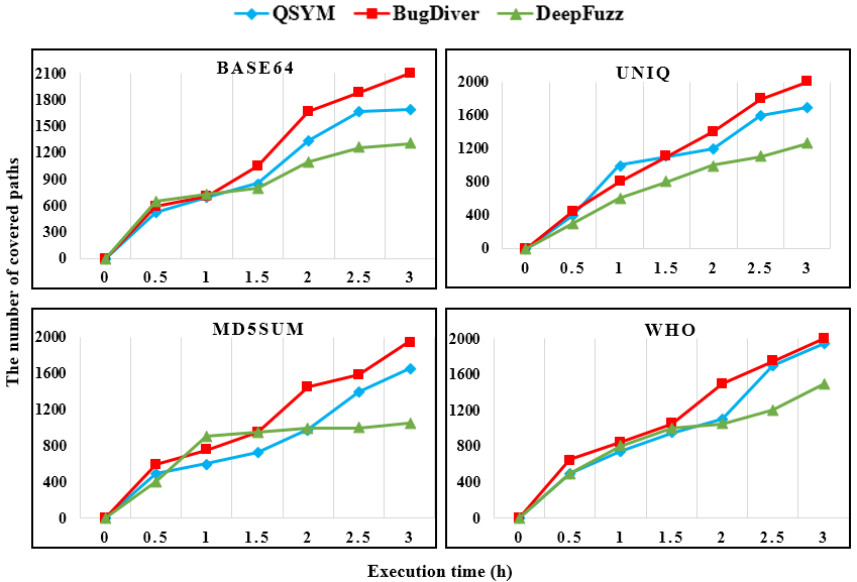
Figure 4. Number of covered paths in the LAVA-M